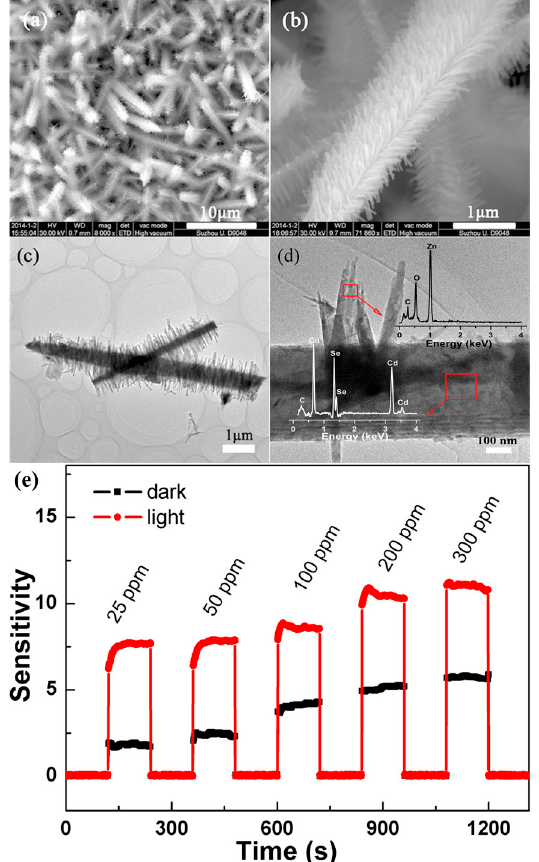
Figure 45. SEM images of ( a ) ZnO nanorods/CdSe nanoribbons heterostructure (HS) and ( b ) an individual ZnO/CdSe HS in high magnification; ( c ) TEM image and ( d ) Energy dispersive X-ray spectroscopy (EDS) spectrum of ZnO/CdSe HS; ( e ) Response of ZnO/CdSe HS-based sensors towards ethanol (25–300 ppm) in the dark and under visible light illumination. Reproduced with permission from [71].